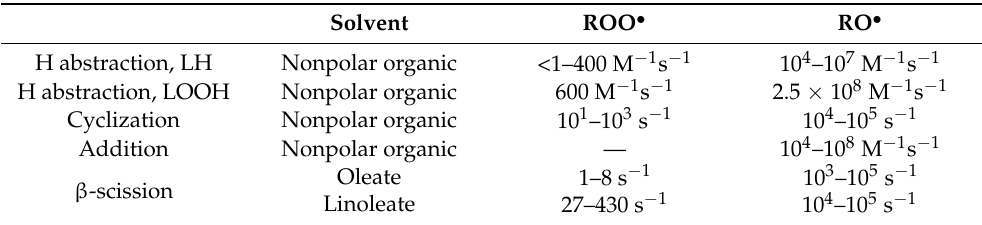
Table 1. Rate constants for alternate reactions of peroxyl (ROO • ) and alkoxyl (RO • ) radicals competing with H abstraction.Data extracted from reference